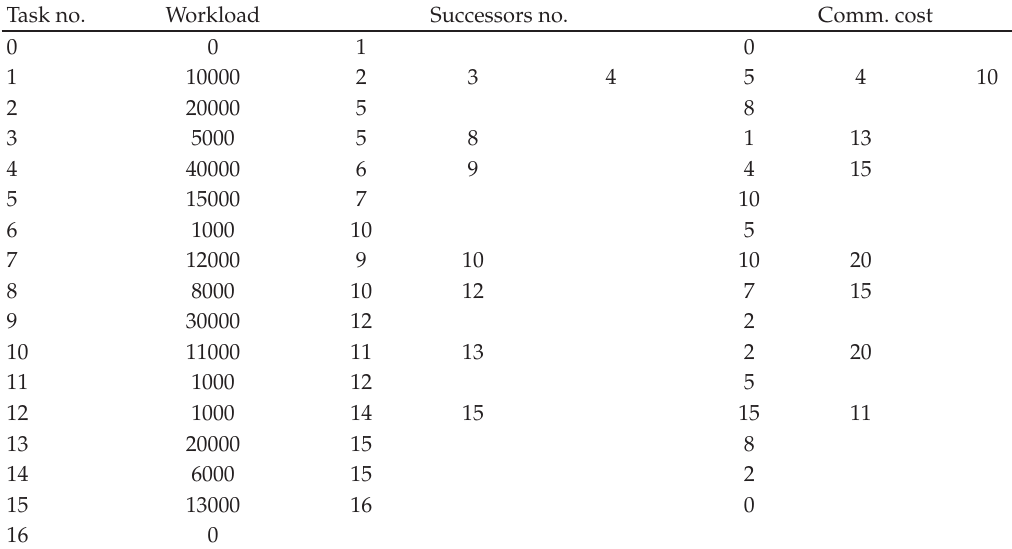
Table 11: A case consisting of 15